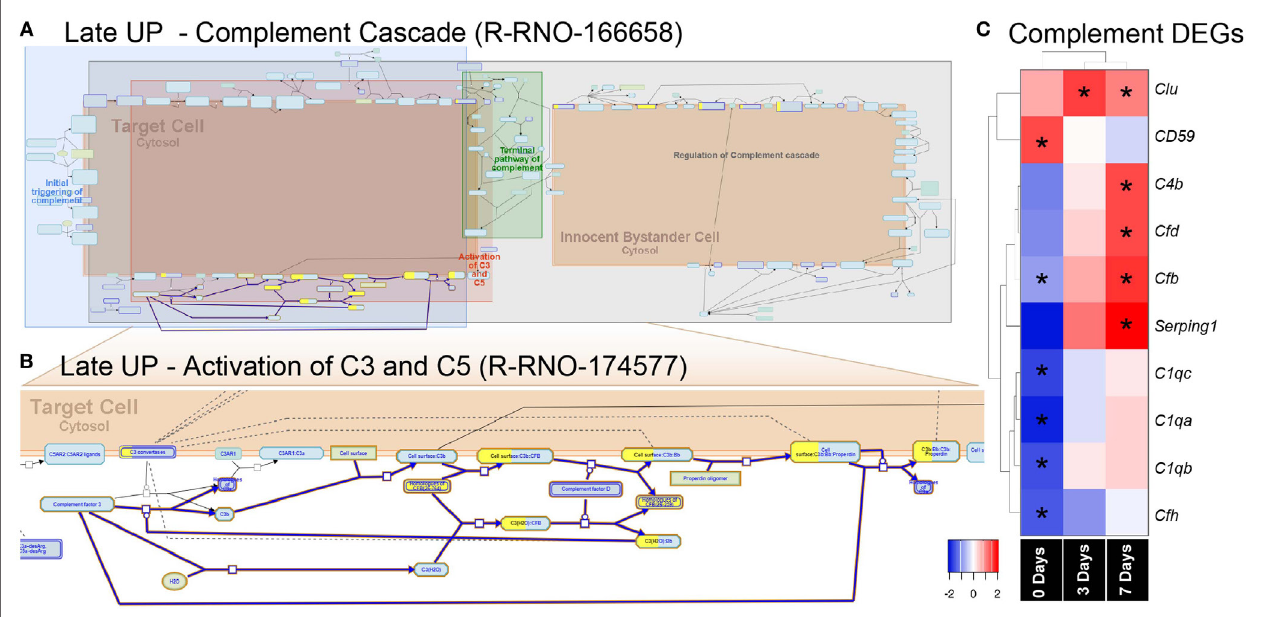
FigUre 5 | Enrichment of the complement pathway in the CD45 transcriptome. (a,B) Reactome pathway diagrams showcase overrepresentation [false discovery rate (FDR) < 0.05] of complement interactions in the Late UP K -means Cluster. Yellow-coloring in the nodes denotes a gene in the expression list that matches a protein within the pathway diagram, while the degree of coloring represents the coverage. (a) Pathway diagram depicts the entire complement cascade, which are broadly classified subcomponents for initial triggering of complement (blue), terminal pathway of complement (green), activation of C3 and C5 (red), and regulation of the complement cascade (gray). (B) Activation of C3 and C5 was found to show significant enrichment Factor B ( cfb ) in the expression list (yellow-coloring). (c) Heat maps with hierarchical clustering on significant complement DEGs derived from the full gene expression list (2,193). Asterisks denote significant differential expression (FDR < 0.05) compared to control (dim). Abbreviation: DEG, differentially expressed